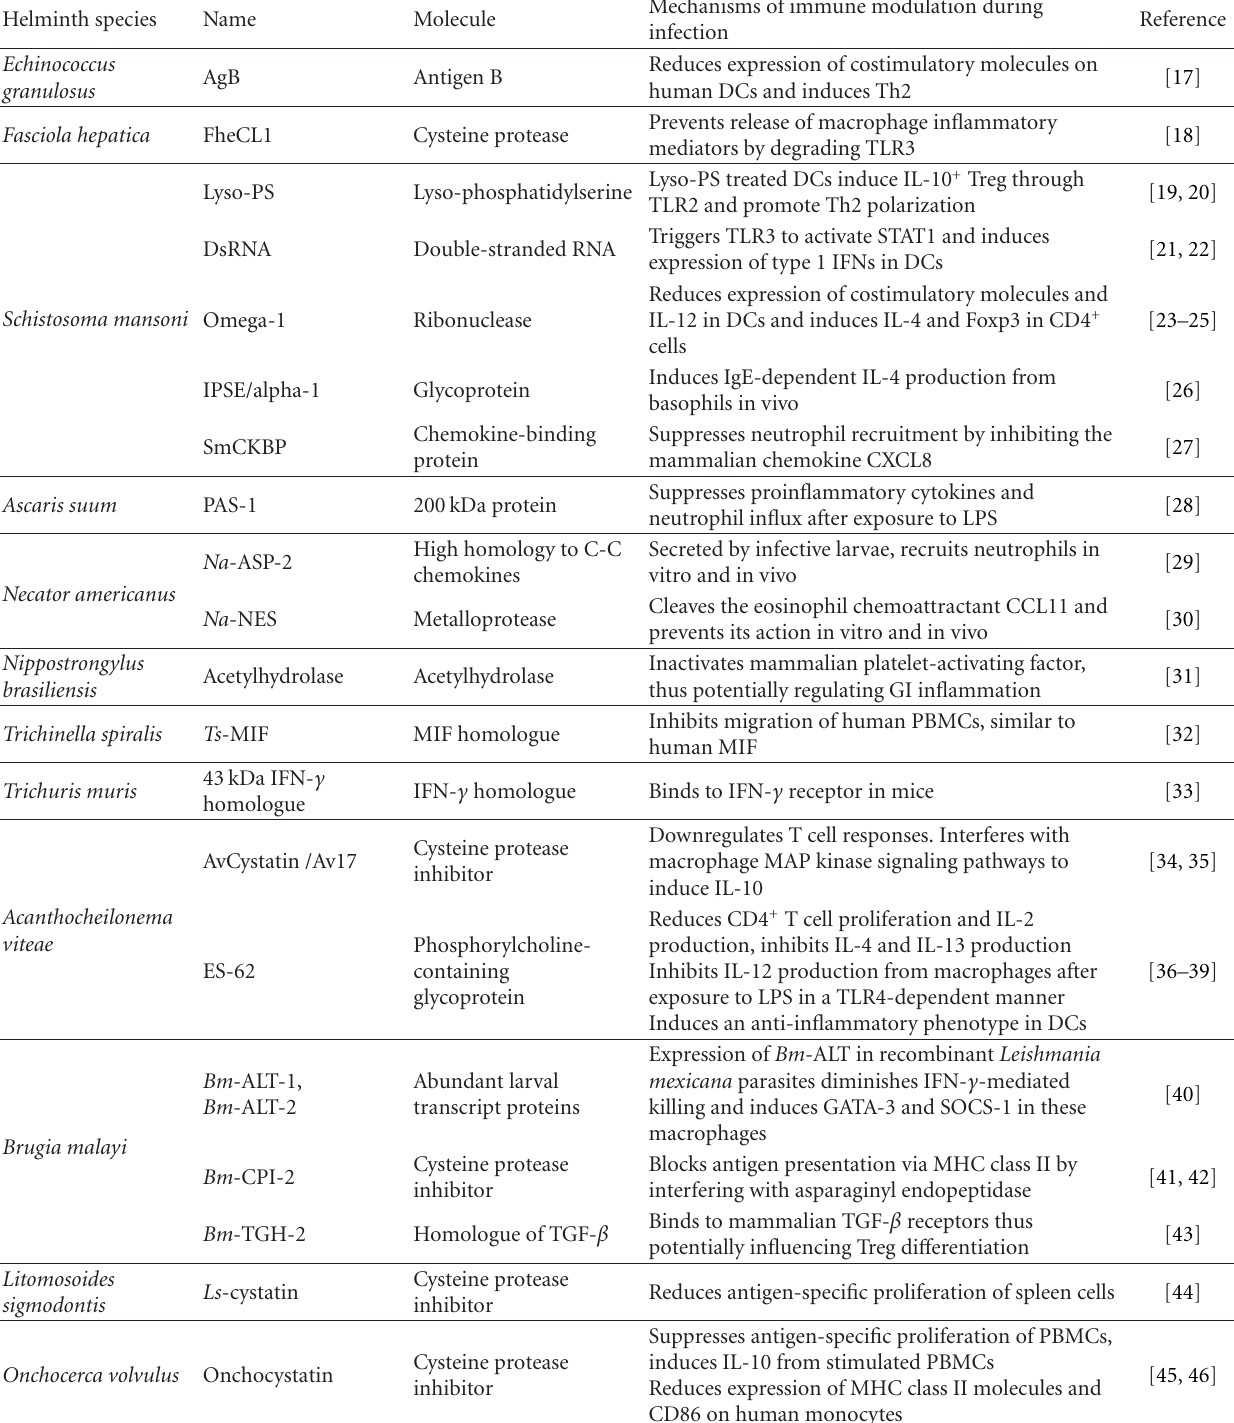
Table 1: Helminth-derived immunomodulatory and Th2-inducing molecules. CXCL: chemokine ligand; DC: dendritic cell; Ig: immunoglobulin; GI: gastrointestinal; IFN- γ : interferon gamma; IL: interleukin; LPS: lipopolysaccharide; MAP: mitogen activated kinase; MHC: major histocompatibility complex; MIF: macrophage migration inhibitory factor; PBMC: peripheral blood mononuclear cell; STAT: signal transducer and activator of transcription; TGF: transforming growth factor; Th: T helper cell; TLR: Toll-like receptor; Treg: T regulatory